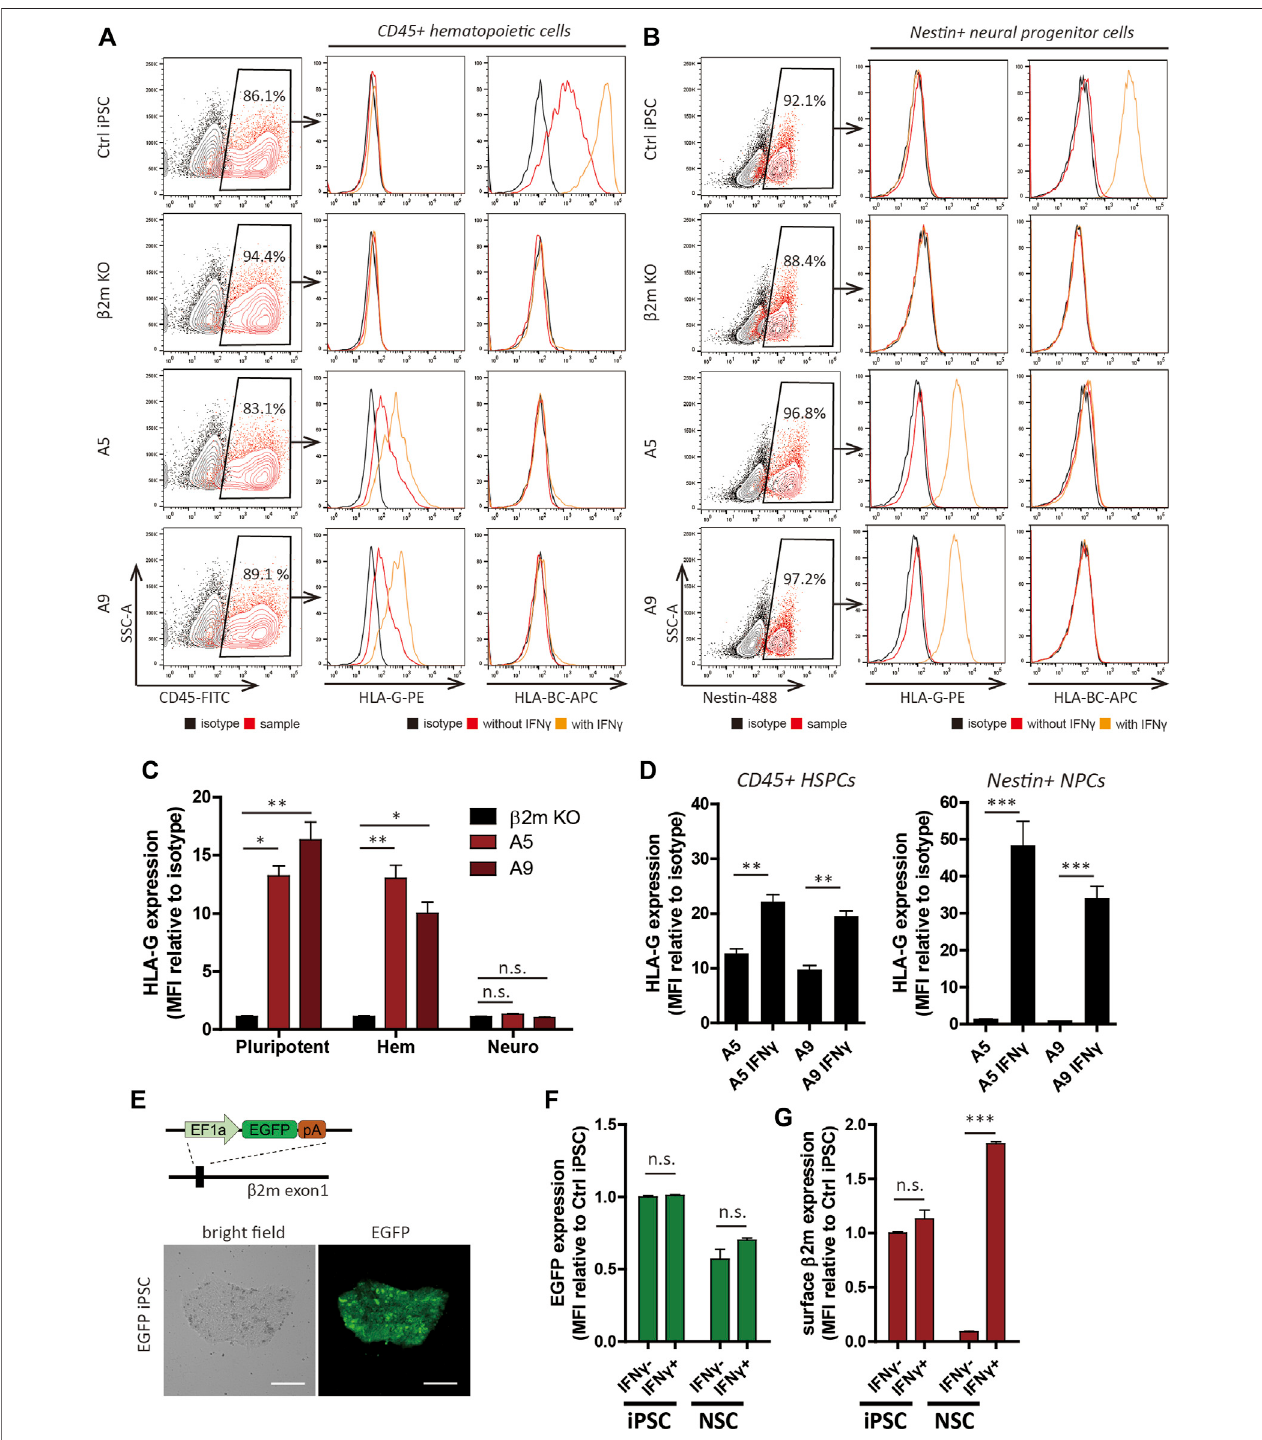
FIGURE 3| Differentiation and HLA expression pro fi les of hypoimmunogenic cell lines. (A,B) Characterization of CD45 + hematopoietic progenitors (A) and nestin + neural progenitor cells (B) derived from the cell lines. HLA-G and HLA-BC expression patterns with (orange) or without (red) IFN- γ , determined by fl ow cytometry. (C,D) RelativeMFIofHLA-Gcompared totheisotypecontrol( n =3).MFIofpluripotentcells(pluripotent),CD45 + hematopoieticlineagecells(Hem),Nestin + neurallineagecells (Neuro) under control ( (C) , n = 3) and IFN- γ -treated ( (D) , n = 4) conditions. (E) Schematic of generation of the EGFP cell line (upper) and light and fl uorescence micrographs. Scale bar, 250 μ m. (F,G) EGFP expression patterns in EGFP cells (F) and surface β 2m expression patterns in WT cells (G) of iPSCs and NSCs with or without IFN- γ by fl ow cytometry ( n = 3). Data are means ± SEMs. N.s., not signi fi cant. * p < 0.05, ** p < 0.01, *** p < 0.001.